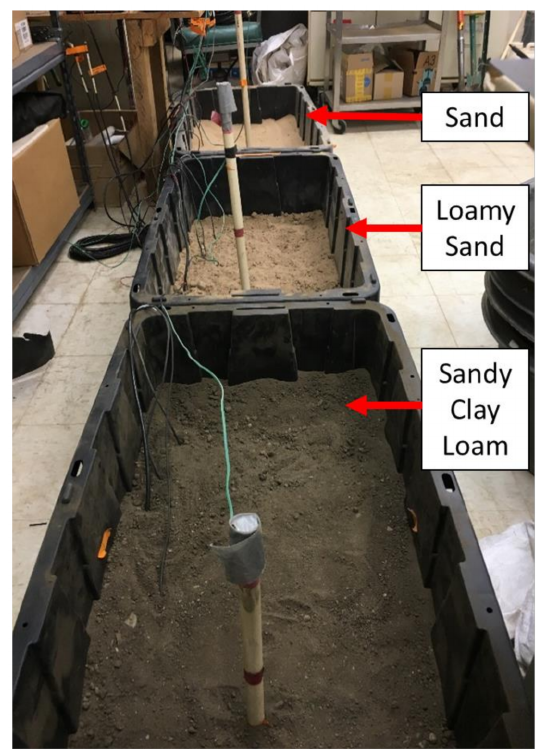
Figure 1. Overview of the laboratory experiment setup. Sand, loamy sand, and sandy clay loams, collected from Michigan agricultural fields, were used in this laboratory